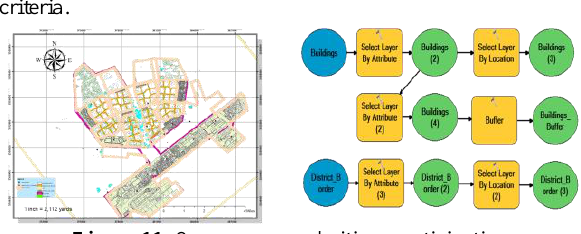
Figure 11. Governance and citizen participation